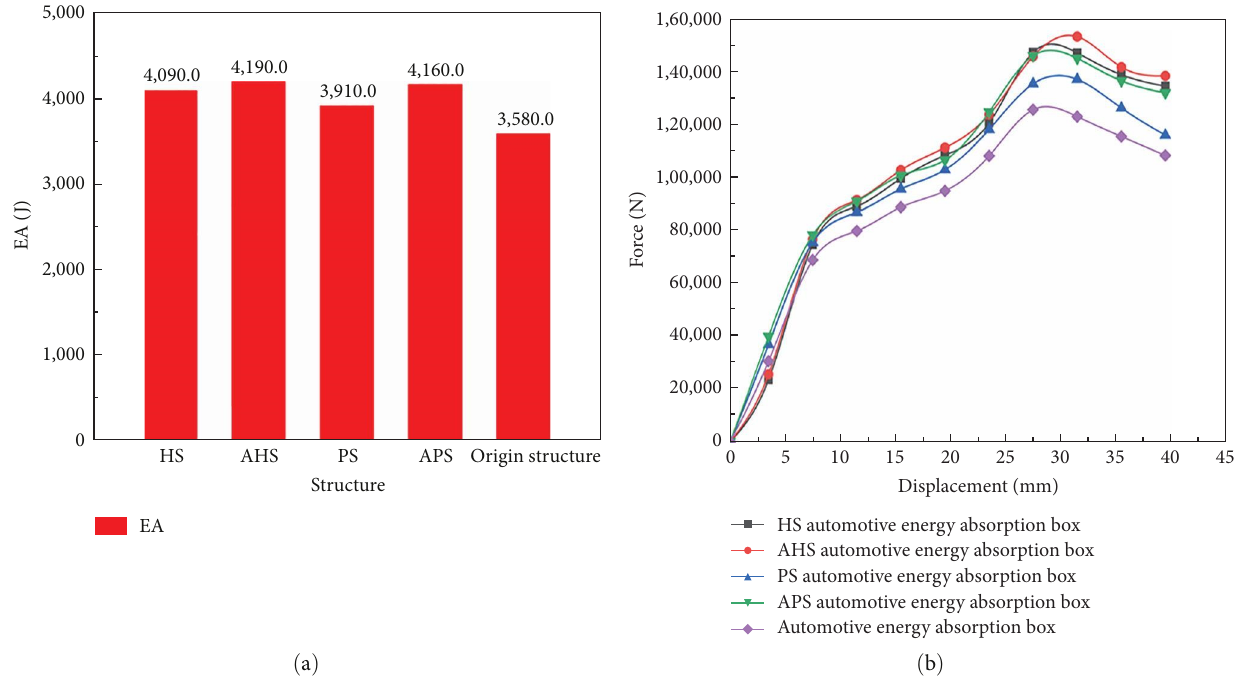
F IGURE 8: The mechanical characteristic of bionic automotive energy absorbing box structures: (a) the EA histogram of bionic automotive energy absorbing box structures; (b) the simulation force – displacement curves of bionic automotive energy absorbing box